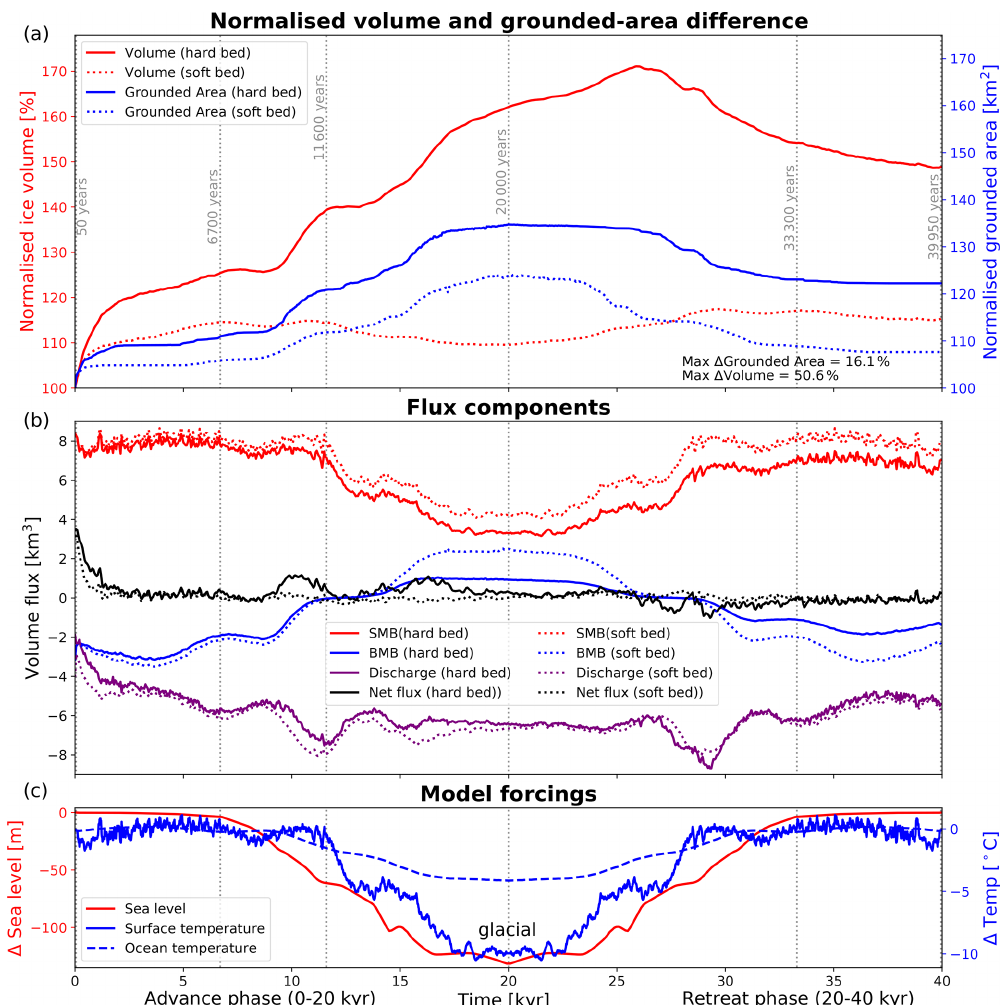
Figure 8. Ice sheet evolution and model forcing for soft- and hard-bed simulations. (a) shows volume and grounded-area evolution normalised to present day. (b) shows corresponding mass balance fluxes, and (c) shows most important model forcings. Vertical stippled grey lines show time slices shown in Figs. 6, 7, 9, and